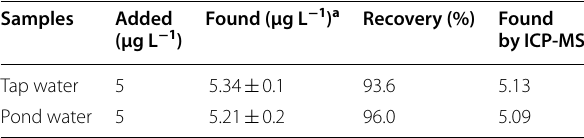
Table 1 Results for the determination of Cr(VI) ions in different environmental